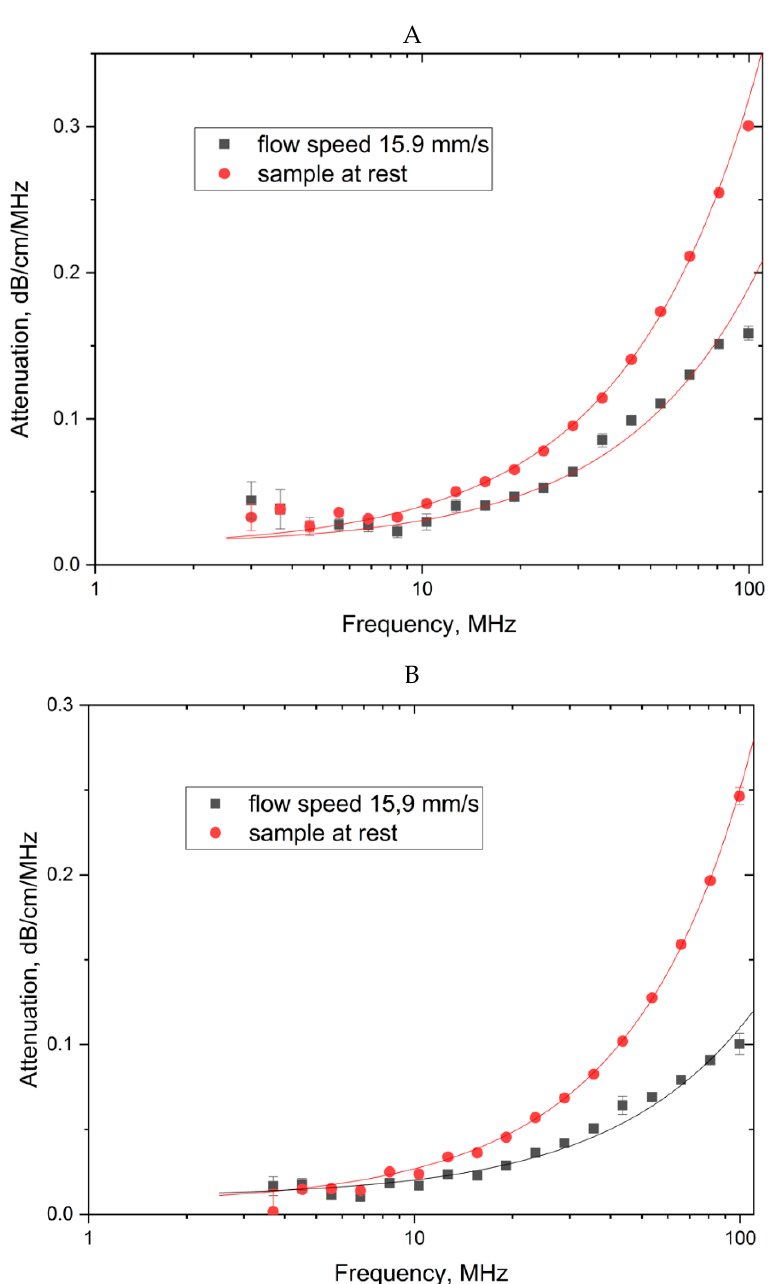
Figure 8. Ultrasound attenuation spectra measured in a CNT dispersion: The red lines denote the spectra obtained at a random alignment of the nanotubes, the black ones show the spectra reflecting the nanotubes predominantly aligned along the flow, perpendicular to the ultrasonic wave direction. ( A )—CNTs before RESS, ( B) —CNTs after RESS.